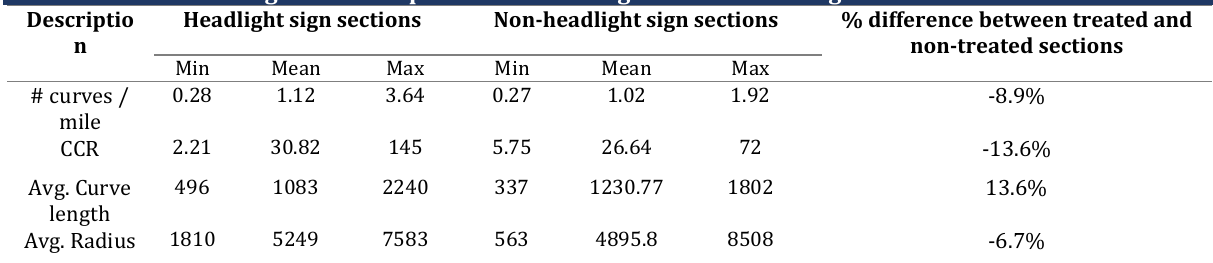
Table 4: Horizontal Alignment Comparison for Headlight to Non –Headlight Sections